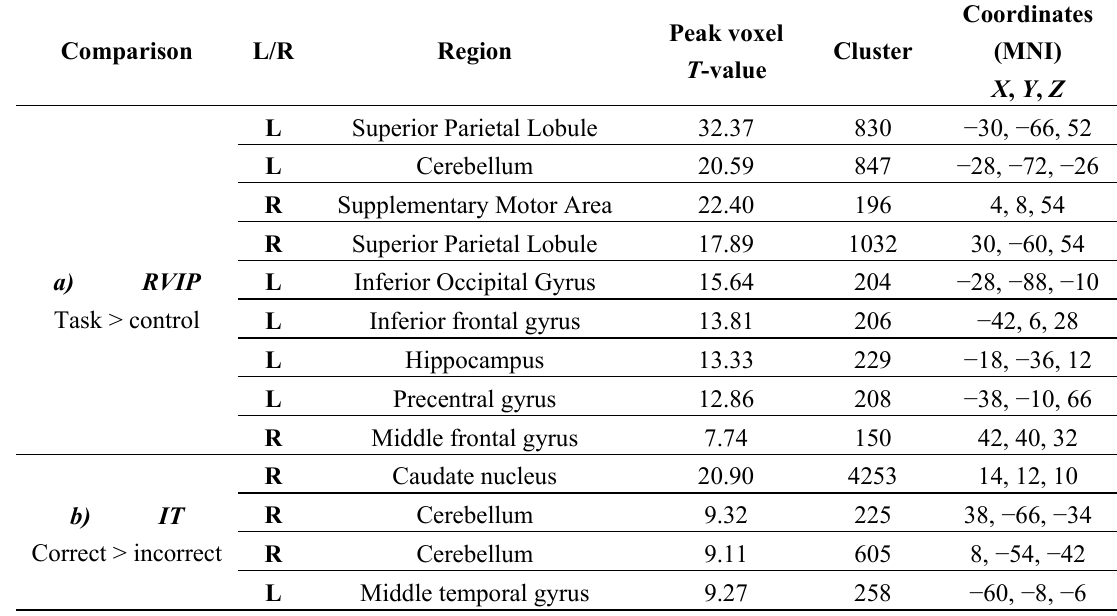
Table 3. Areas of BOLD activation during ( a ) the Rapid Visual Information Processing (RVIP) task and ( b ) the Inspection Time (IT) task; L = left, R = right, MNI = Montreal Neurological